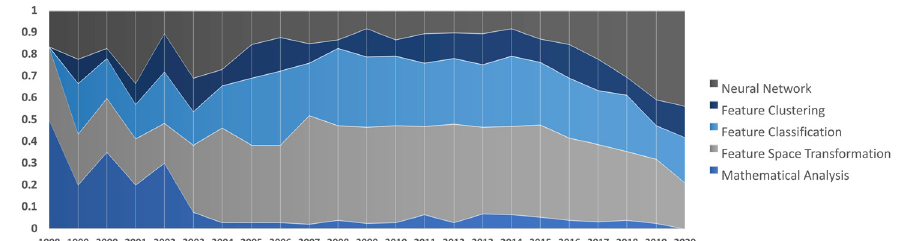
Figure 10. Proportion statistic chart of five mainstream factions for change extraction from 1998 to April 2020. The proportion of each faction in the total annual statistics is calculated with statistic results retrieved from Web of Science with keywords of remote sensing and the names of pivotal methods.